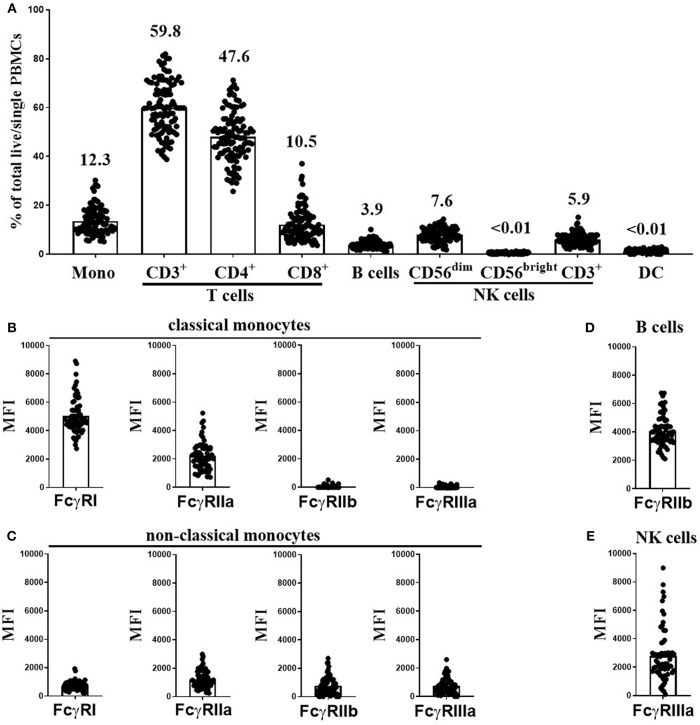
Immune cell subset frequencies and FcγR expression on PBMCs from healthy donors. Immune cell subset frequencies and FcγR expression on freeze-thawed PBMCs using flow cytometry. (A) Quantification of monocytes (Mono), CD3+, CD4+, and CD8+ T cells, B cells, CD56dim, CD56bright, and CD3+ NK cells and dendritic cell (DC) frequencies in freeze-thawed PBMCs from healthy human subjects (mean frequency of each cell subset stated above bar). FcγR expression on (B) classical, and (C) non-classical monocytes, (D) FcγRIIb expression on B cells and (E) FcγRIIIa expression on CD56dim NK cells (n = 107). Each point represents a donor, bars represent group means.